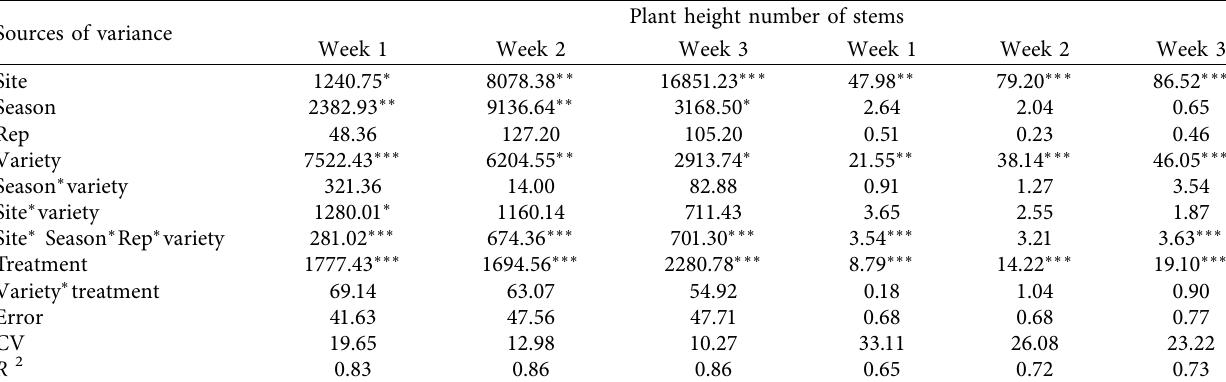
Table 8: The mean squares of three potato varieties on plant height and number of stems at different weeks after plant emergence. Sources of